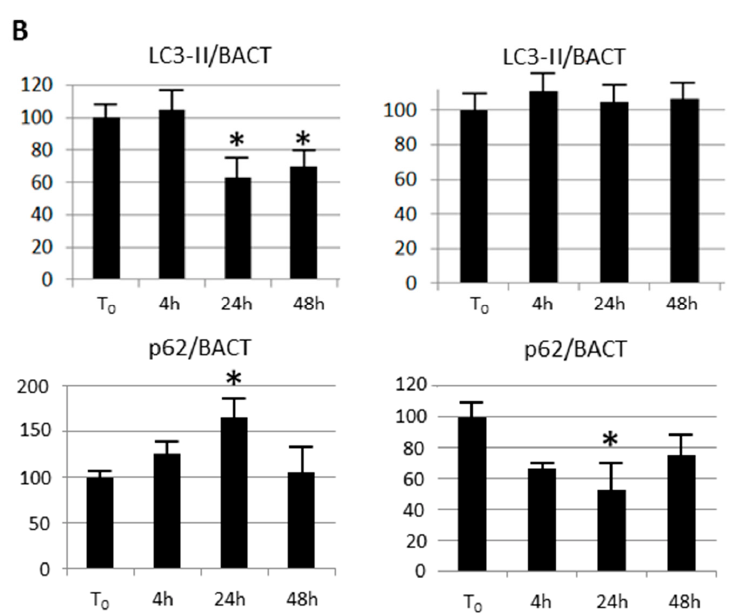
Figure 9. Immunoblotting analysis of LC3-II and p62 expression in Caco-2 cells after PT-gliadin or ovalbumine administration. ( A ) PT-gliadin ( left ) or ovalbumin ( right , both at 1 µg/µL) were administered to Caco-2 cells. ( B ) LC3-II, p62 and BACT protein expression was analysed using immunoblotting and densitometric analyses. LC3-II and p62 were normalized to BACT levels as recommended [22]. Molecular weights (in kDa) are indicated. Asterisks indicate p < 0.05, Anova One-way, compared to T 0 untreated sample.